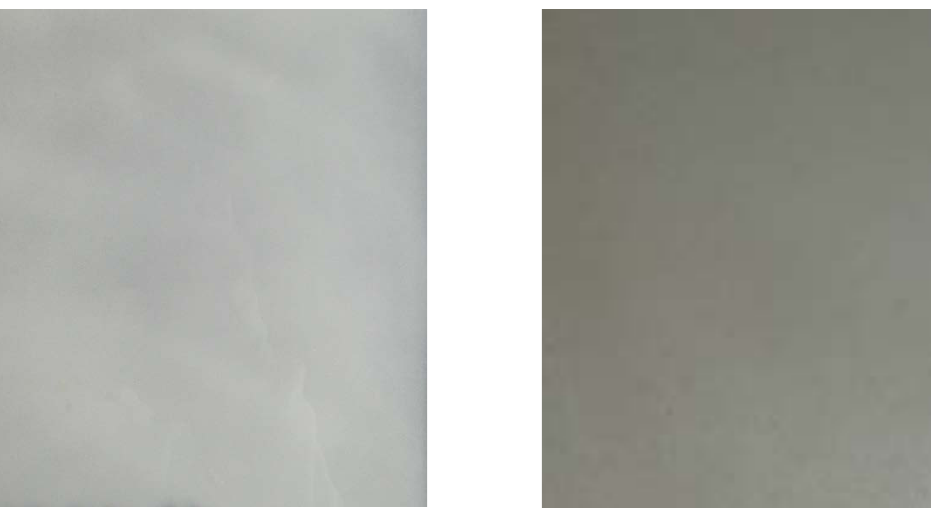
Fig. 13 Sample EVA 1 and paint sprayed on the glass before the aging process